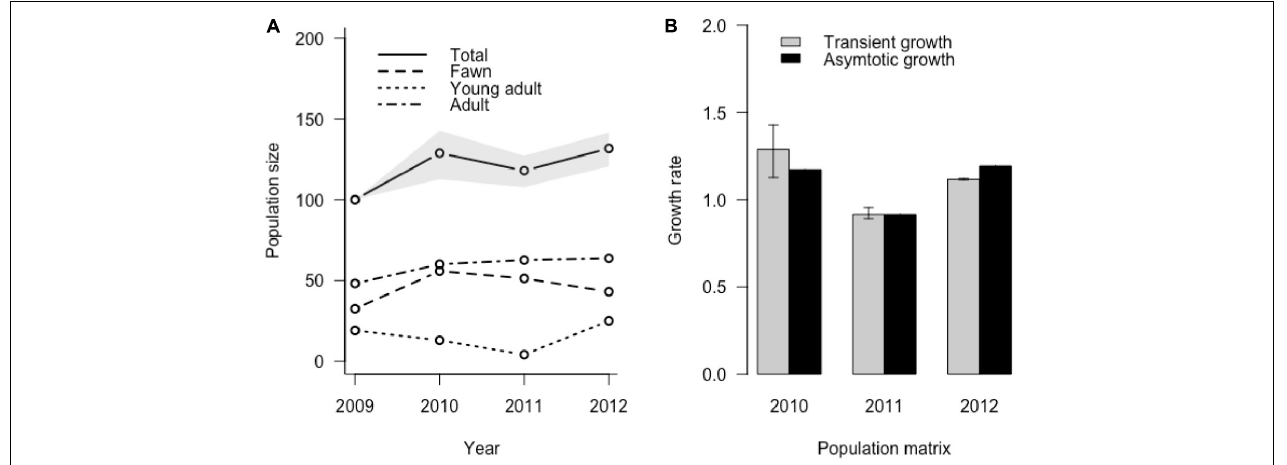
FIGURE 6 | Realized population change for the Sitka black-tailed deer population, incorporating simulated uncertainty in initial stage distribution in 2009 and based on a starting size of 100 individuals; (A) shows population size in total and in each stage, and (B) shows transient versus asymotic growth rate produced by each year’s projection matrix, during the years of the study (2010–2013) on Prince of Wales Island, AK, United